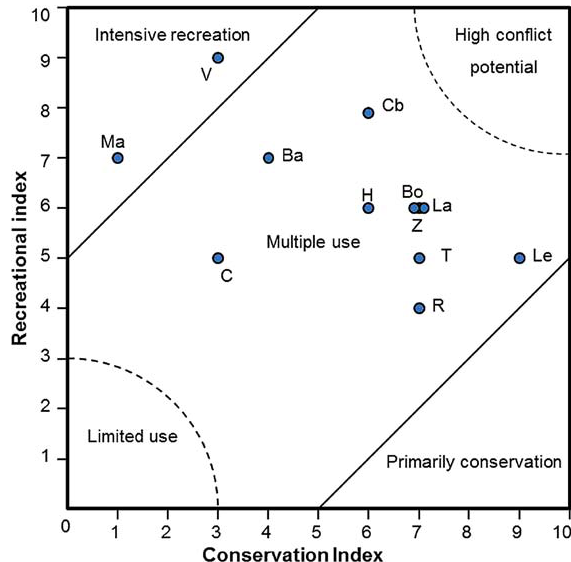
Fig. 6. – Location of each beach listed in Table 2 relative to its conservation index and recreation potential index scores. The plot shows the demarcation of beaches for intensive recreation, conser- vation and multi-purpose use. H, Hoyo; T, Terrón; Bo, Bota; M, Mazagón; Ma, Matalascañas; Cb, Costa Ballena; V, Valdelagrana; Le, Levante; C, Cortadura; Ba, Barrosa; Z, Zahara; La,